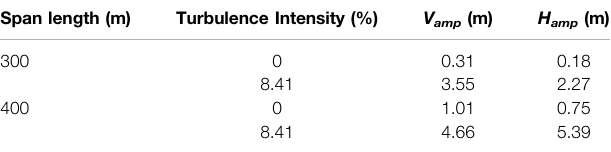
TABLE 6 | RMS amplitude of galloping behaviors under different span lengths. TABLE 7 | RMS amplitude of galloping behaviors under different turbulence